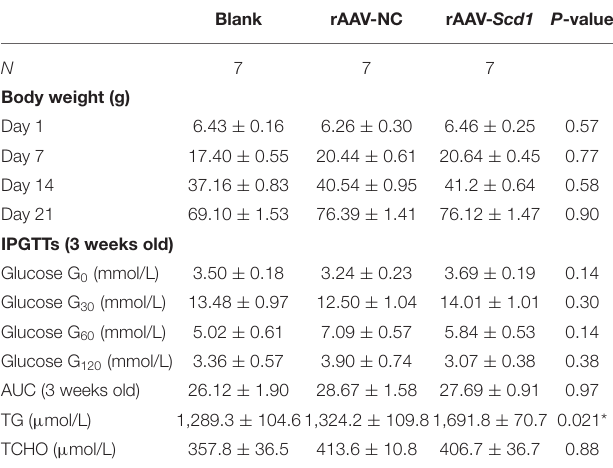
TABLE 2 | Biochemical parameters of newborn rats injected with rAAV. Blank rAAV-NC rAAV- Scd1 P